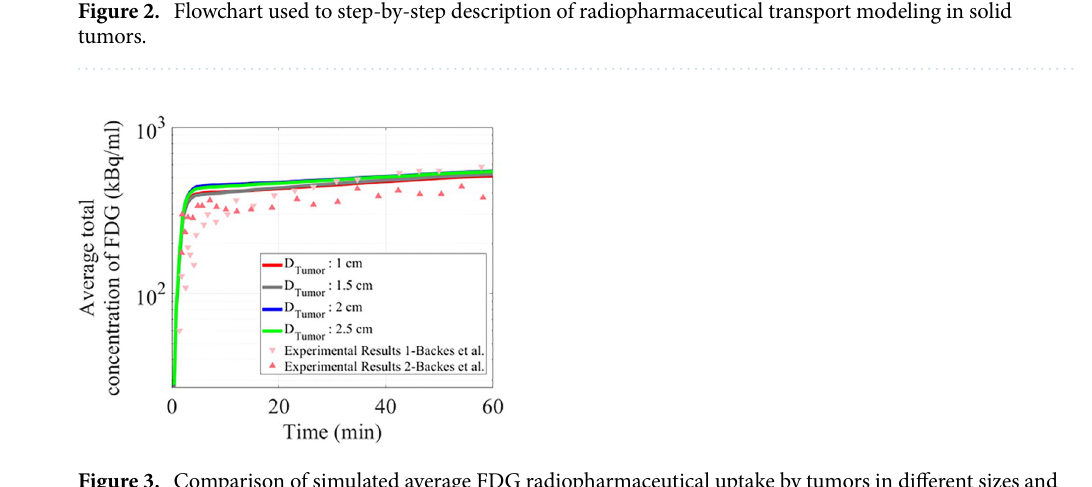
Figure 3. Comparison of simulated average FDG radiopharmaceutical uptake by tumors in different sizes and the experimental results of Backes et al. 36